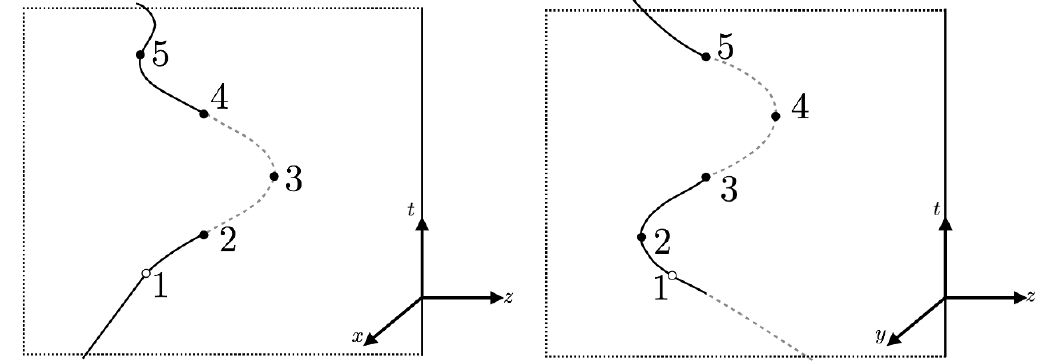
Figure 4 . Two projections of the worldsheet traced out by the string, in a frame where the monopole (solid vertical line) is at rest at the origin, and the string lies along the negative z -axis. The (cid:12)gure on the left shows a projection where space is projected onto the x - z plane, while the (cid:12)gure on the right shows space projected onto the y - z plane. The same time-ordered sequence of points that were shown in (cid:12)gure 2 is labeled 1-5 in both diagrams. The solid curving line indicates the path of the charged particle when it is in front of the worldsheet, while the dashed curving line indicates its path when it is behind the